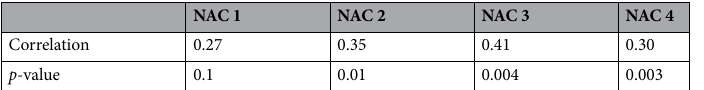
Table 3. Correlation between echogenicity and IBC after subsequent NAC